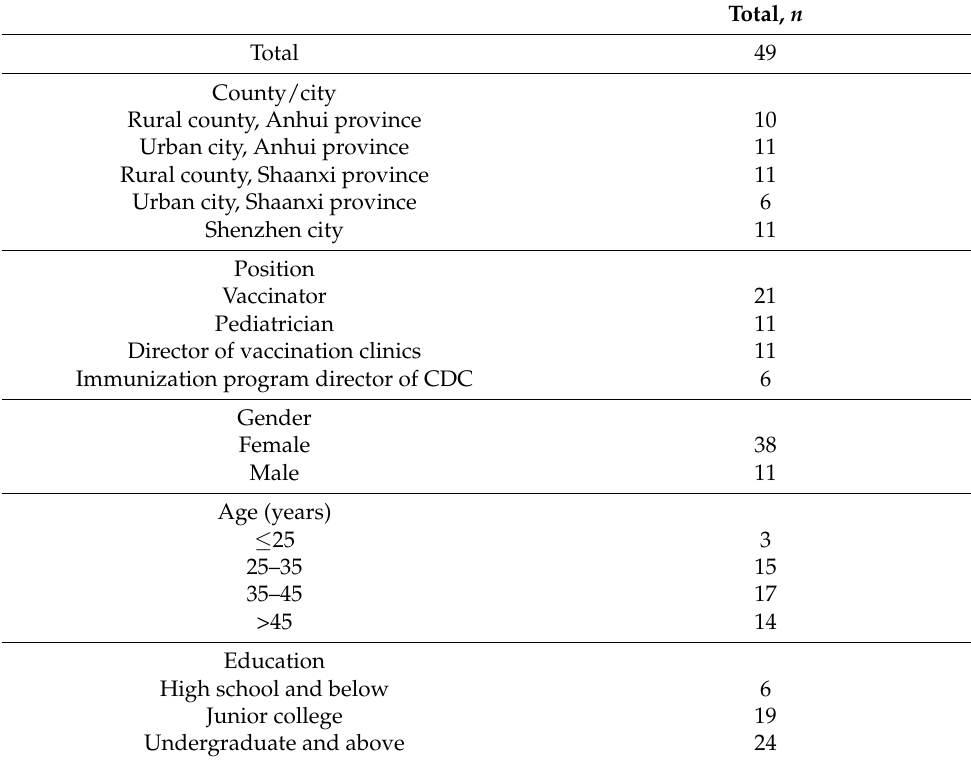
Table 2. Characteristics of vaccination service providers participating in the